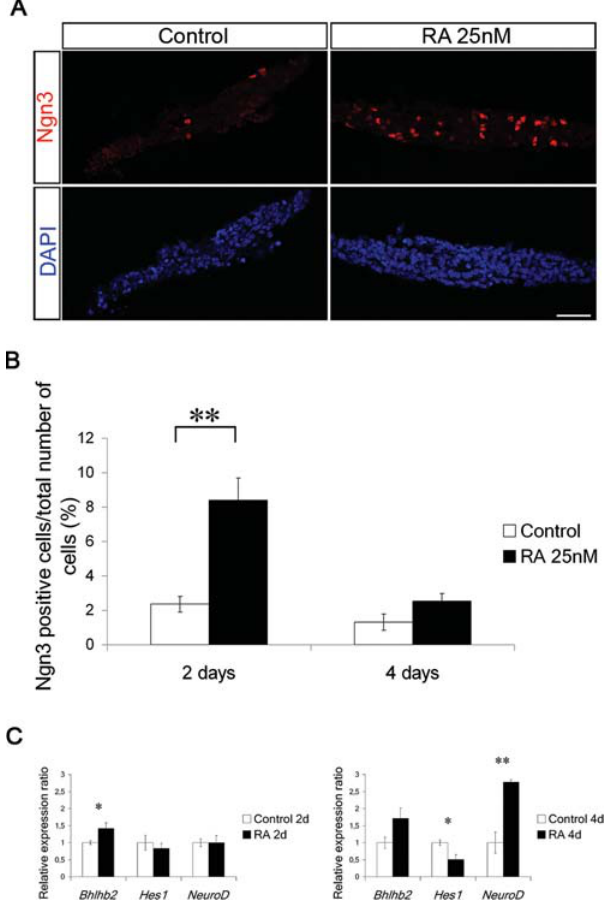
Figure 3. RA induces Ngn3 expression invitro . ( A ) Representative sections of a control and RA-treated e10.5 dorsal pancreatic explants cultured for 2 days and stained with antibodies specific for Ngn3. ( B ) Quantification of Ngn3 + cells in control and RA-treated explants cultured for 2 or 4 days (n=4 for each condition) displayed as % Ngn3 expressing cells/total number of cells. ( C ) qRT-PCR using Bhlhb2 , Hes1 and NeuroD specific primers on cDNA from control and RA treated e10.5 pancreatic explants cultured for 2 (n=13) or 4 days (n=9). Data represent the mean value 6 S.E.M. *p , 0.05, **p , 0.01, for RA treated explants versus